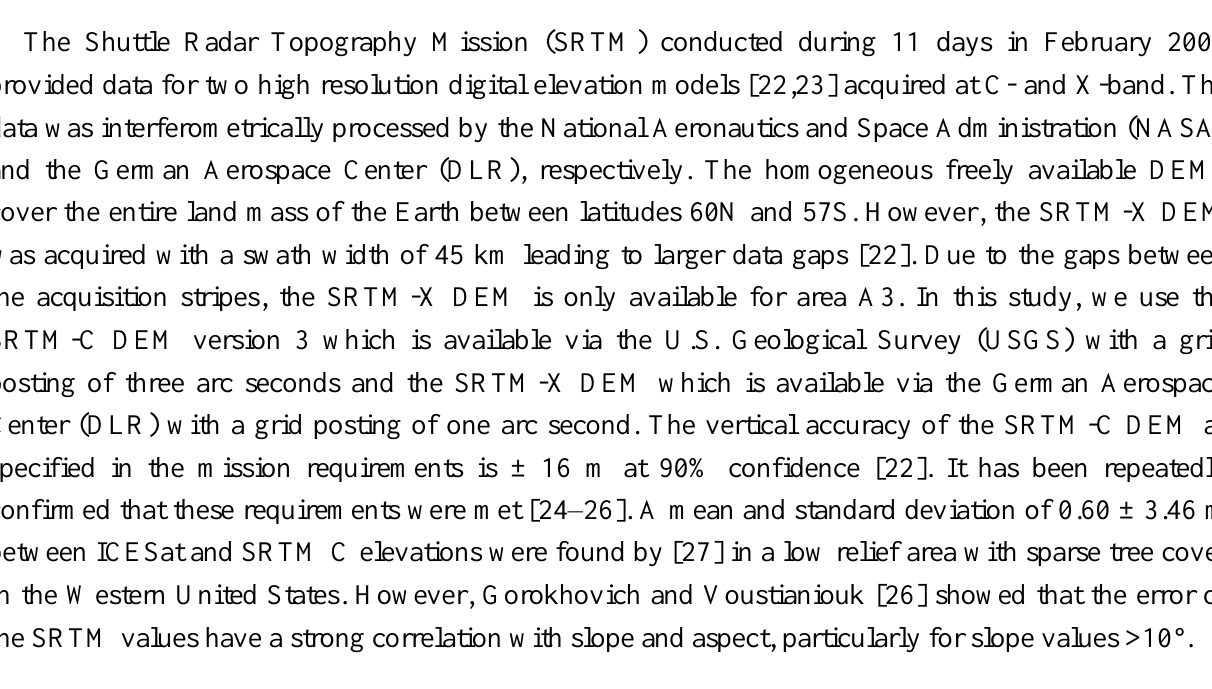
Figure 3. The area A2 (Konkordiaplatz) on different DEMs shown as shaded relief. ( a ) The SRTM-C DEM features a smooth surface with little detail. Artifacts are